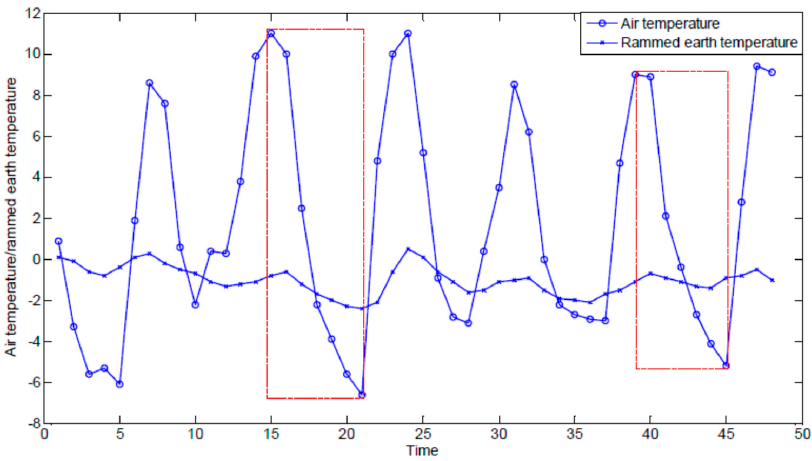
Figure 2. Air temperature and rammed earth temperature sequences.